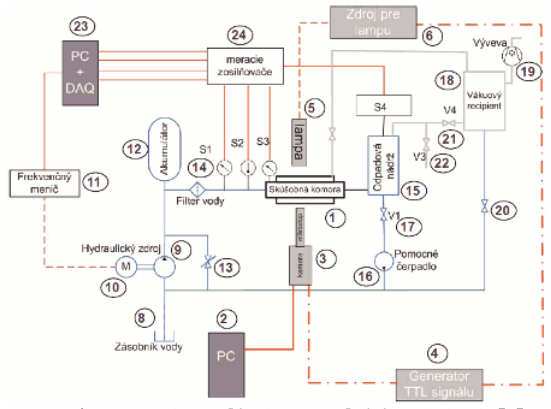
Fig. 3. Experimentaldevice. Detailed description in [1].